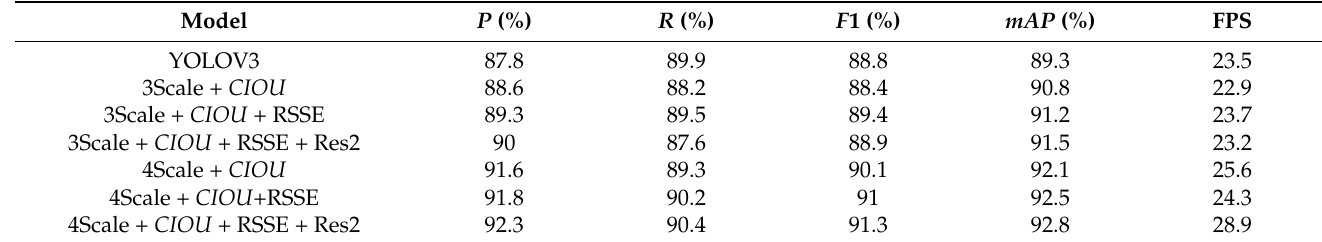
Table 4. Ablation results of different models (608 ×